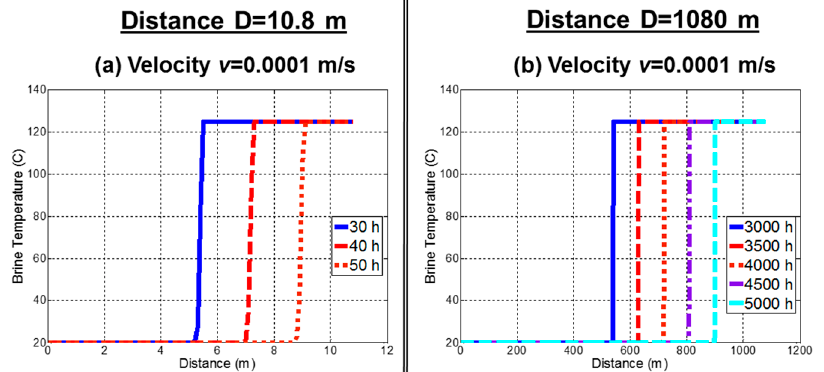
Figure 14. Cont. Figure 14.